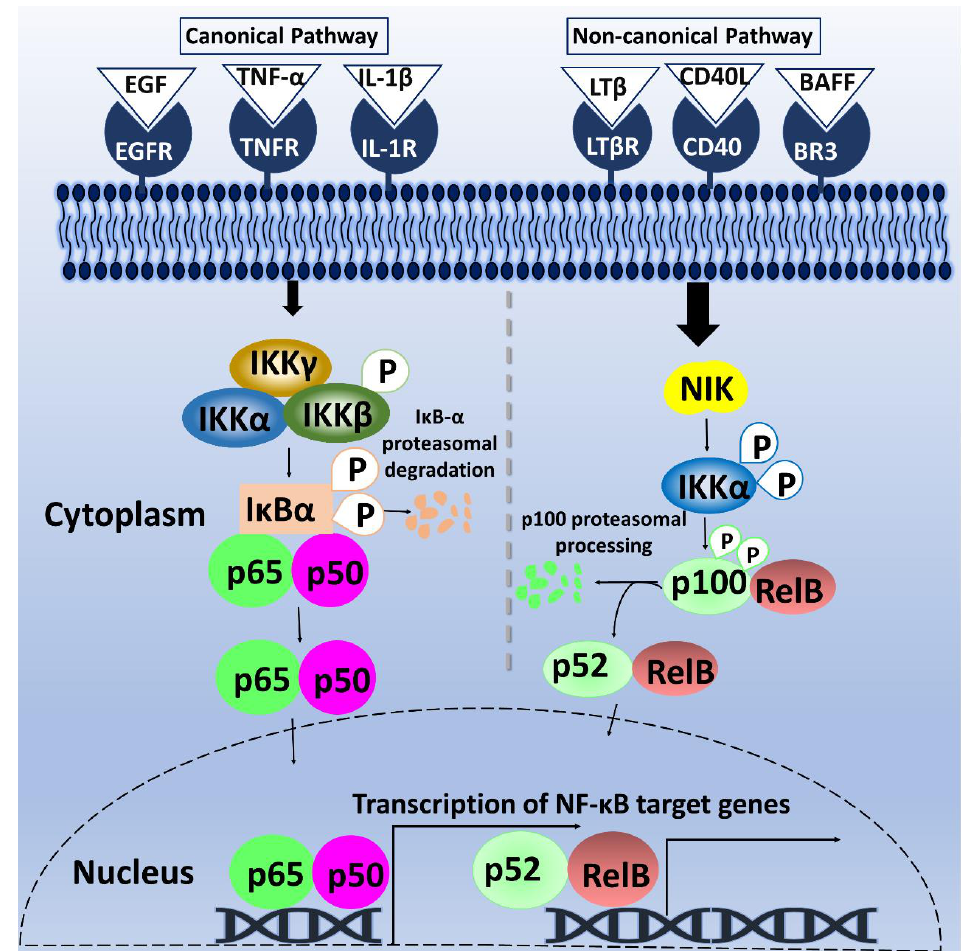
Figure 1. Schematic diagram of NF- κ B canonical and non-canonical pathways. In the canonical pathway, on the left, the stimulation of receptors by cytokine and growth factors lead to the phosphorylation of IKK complex, which in turn phosphorylates I κ B α , leading to its proteasomal degradation. The free p65/p50 dimers of NF- κ B then translocate into the nucleus to bind to κ B motif and promote NF- κ B-dependent gene transcription. On the right, the non-canonical pathway is activated by binding of LT β , CD40L, and B-cell activating factor (BAFF) to their respective receptors, causing NIK-mediated phosphorylation of IKK α . Phosphorylation of p100 by activated IKK α initiates proteasomal processing of p100 N-terminal to form p52. The p52/RelB dimeric complex then undergoes nuclear translocation and binds to its κ B motif, resulting in NF - κB -dependent gene transcription.